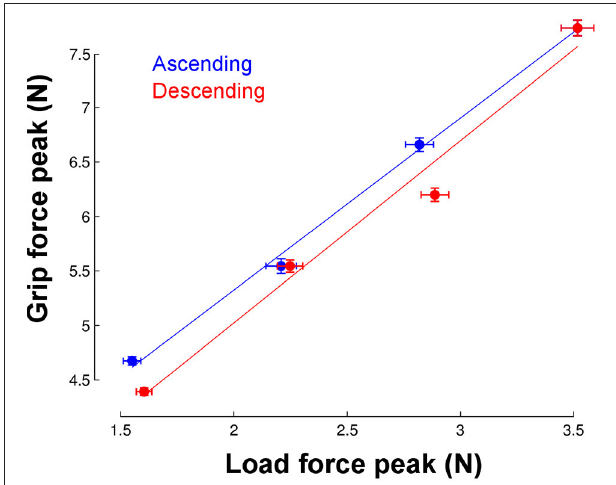
FIGURE 5 | Correlation between load force peaks (x-axis) and grip force peaks (vertical axis) in the first trial and separately for each phase. Each point corresponds to the average across the seven participants in each of the four gravitoinertial contexts. The linear regressions were significant in both ascending ( r = 0.99, p = 0.002, slope = 1.6, offset = 2.2) and descending phases ( r = 0.99, p = 0.012, slope = 1.67, offset = 1.68). Vertical and horizontal error bars correspond to STD. Note that the point in the upper right corner was identical in the ascending and descending phases (only one 2.5g